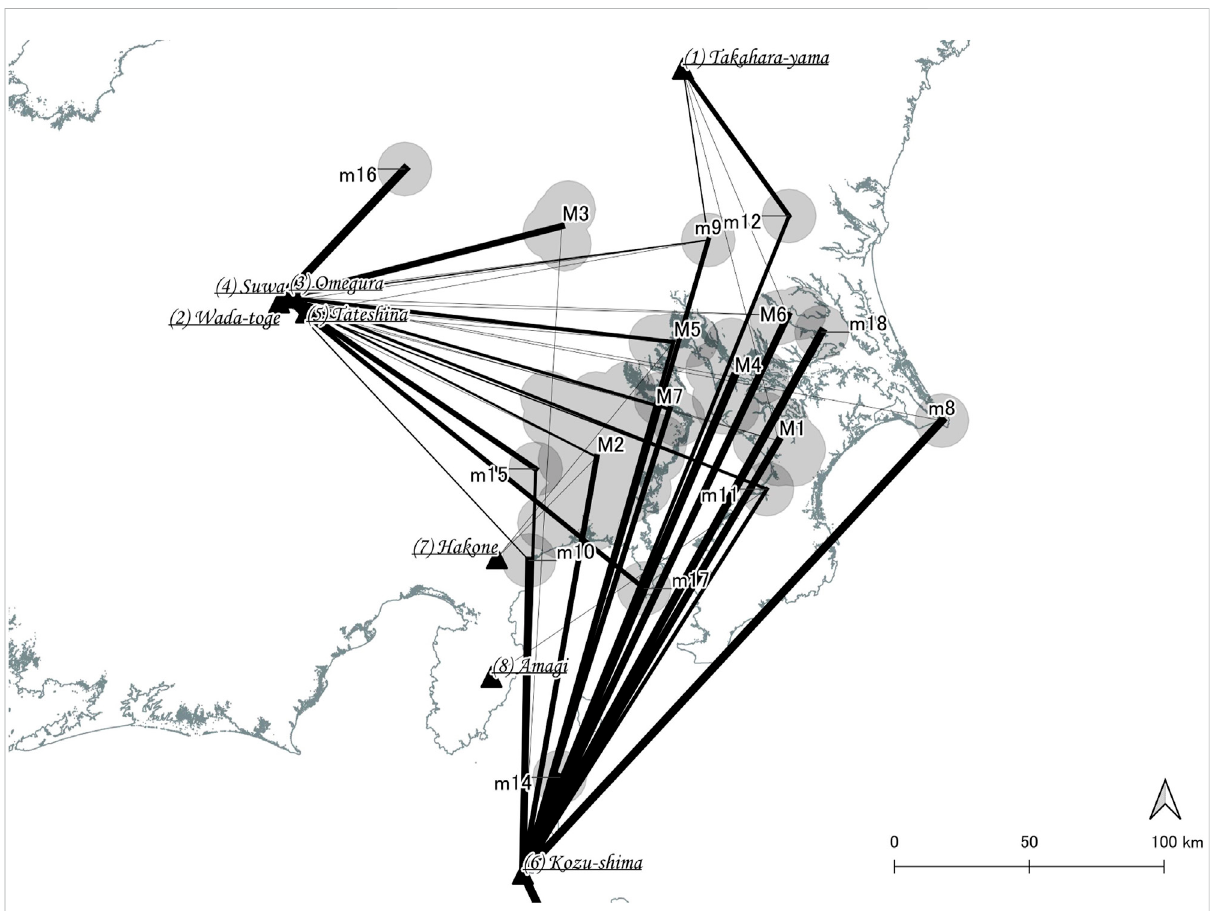
FIGURE 5 Bipartite graphs between provenance and consumption areas in Period 3, the middle Jomon period (5,500 – 4,500 years cal BP). Clusters are represented by uppercase characters and single sites by lowercase characters. The thickness of the links corresponds to the composition ratio of each production area in each cluster (M1 – 7) and each single site (b8 –